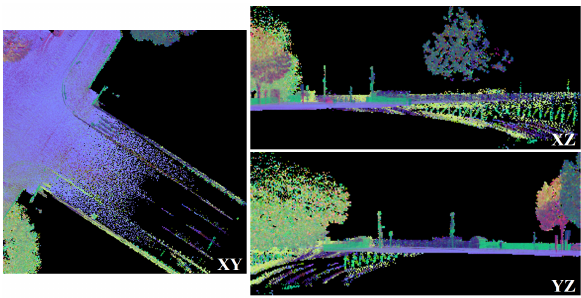
Figure 11. The three images produced from the point cloud set of Figure 1a illustrating normal vector values.